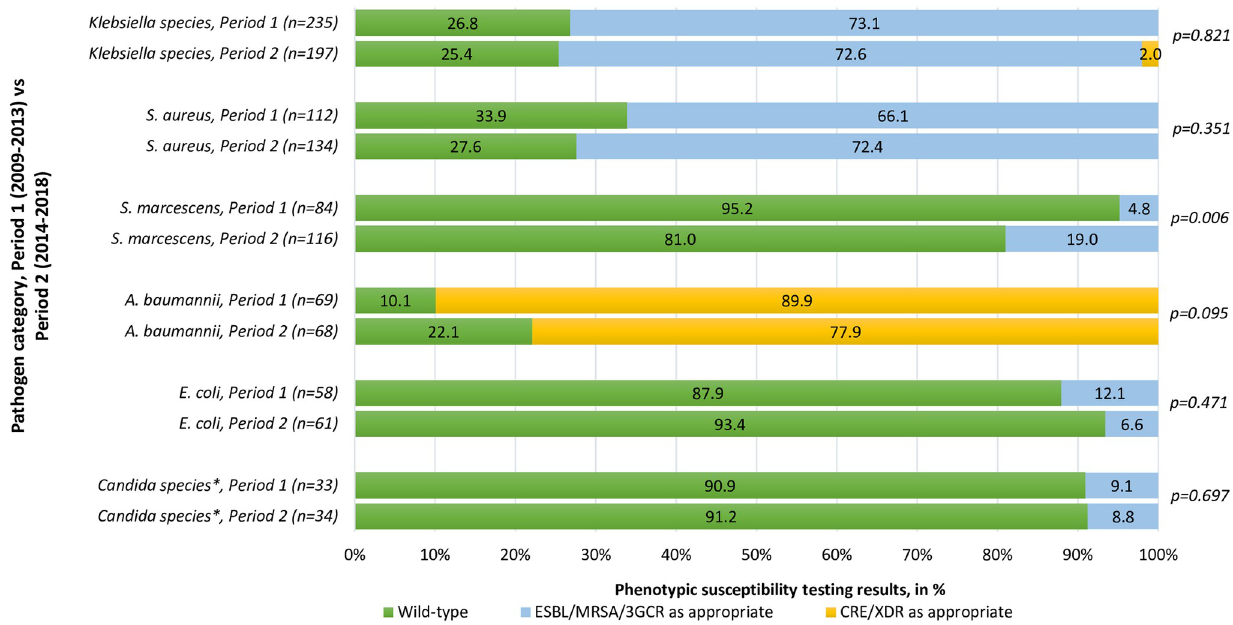
Fig 2. Phenotypic susceptibility patterns for the most commonly isolated pathogens in neonatal hospital-acquired bloodstream infections, Period 1 (2009–2013) vs Period 2 (2014–2018). � Phenotypic susceptibility patterns established using the relevant year’s Clinical and Laboratory Standards Institute (CLSI) breakpoints. Isolates classified according to standard definitions for wild-type and acquired resistance, and reported as a proportion of the total number of isolates per species. Two-sided p-values were used. ESBL: extended-spectrum β -lactamase, detected by third-generation cephalosporin resistance; MRSA: methicillin-resistant S. aureus , detected by cefoxitin resistance;3GCR: 3 rd -generation cephalosporin resistance in chromosomal ampC beta-lactamase producers; CRE: carbapenem-resistant Enterobacterales, detected by reduced susceptibility to any carbapenem (usually ertapenem), in isolates not known to have chromosomally-mediated mechanisms for reduced susceptibility, XDR: extensively drug resistant, classified using a standard definition [14]. � Including Candida spp. with established fluconazole resistance, C. krusei and C. glabrata , which were the only isolates in which fluconazole resistance was found. No C. auris isolates were detected in this setting during the period of